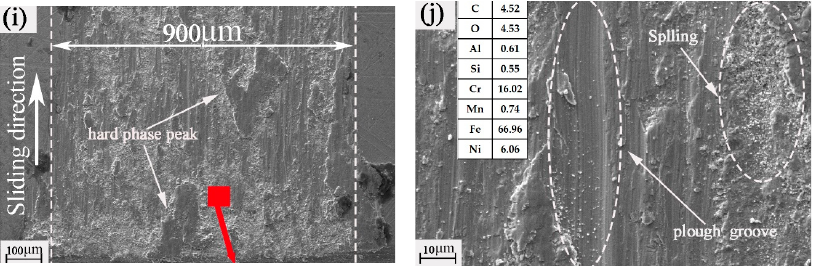
Figure 6. SEM images of the worn plates: ( a , b ) untextured rotation radius 18 mm, ( c , d ) 0.4 mm groove width mechanical texture rotation radius 18 mm, ( e , f ) 0.6 mm groove width mechanical texture rotation radius 18 mm, ( g , h ) 0.8 mm groove width mechanical texture rotation radius 18 mm, and ( i , j ) 1.0 mm groove width mechanical texture rotation radius 18 mm.